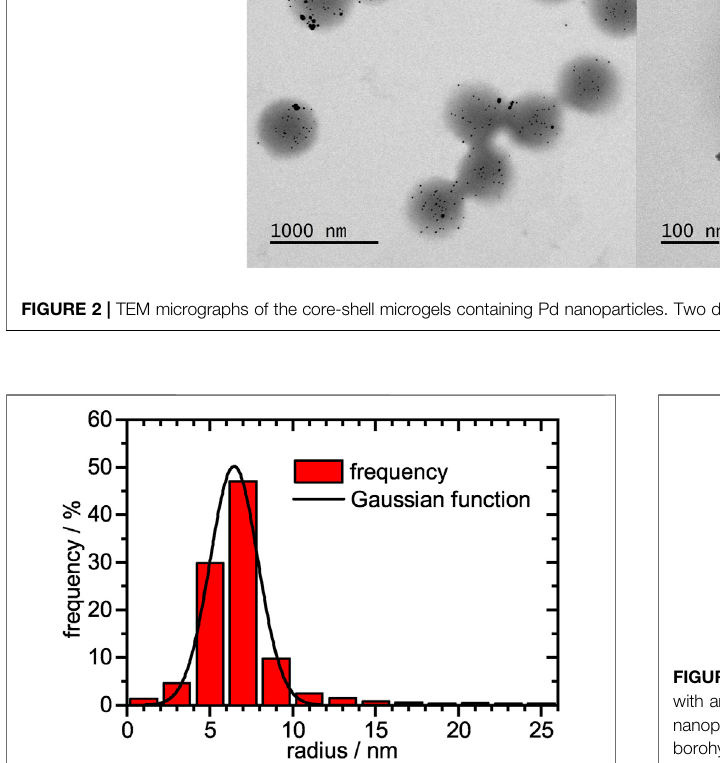
FIGURE 3 | Histogram of the relative frequencies plotted against the nanoparticle radius. The size distribution was fi tted with a single Gaussian function. A total of 2,300 palladium nanoparticles were analyzed. A mean particle radius of (6.4 ± 1.4) nm was obtained.